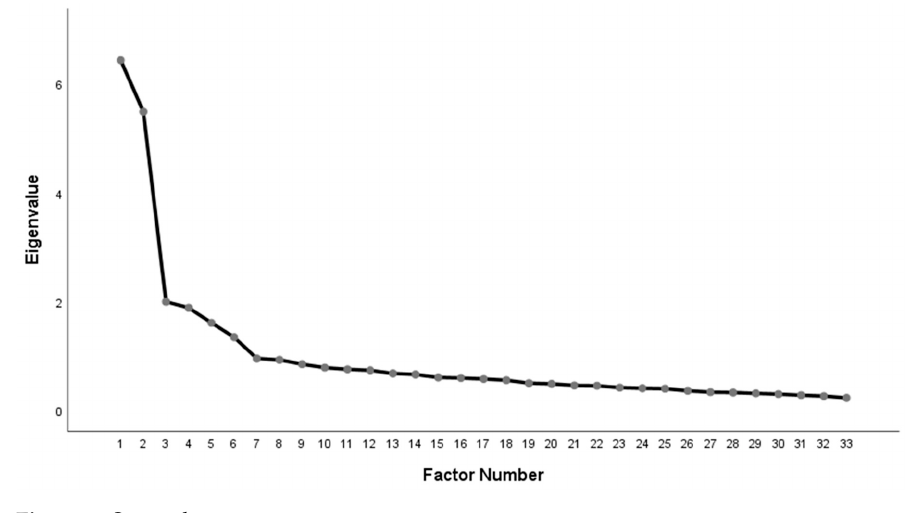
Figure 1. Scree plot. Table 3. Descriptive statistics and factor correlation